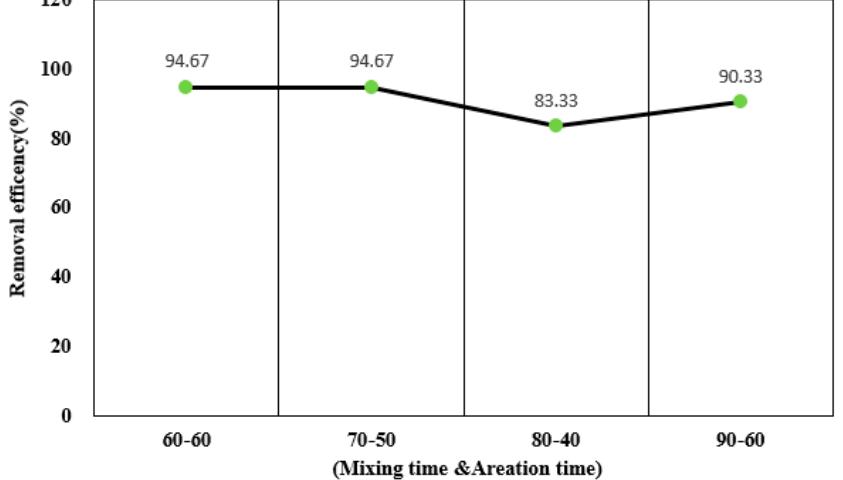
Figure 6. Changes in removal efficiency based on changes in mixing: aeration times (COD Cr ).